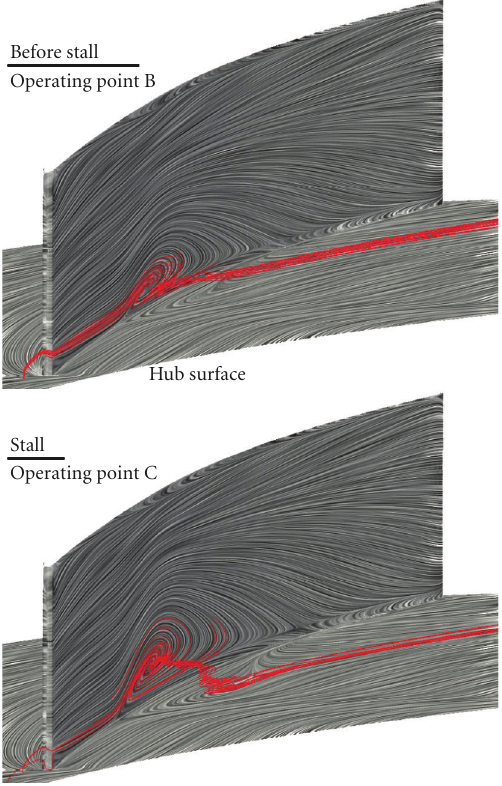
Figure 11: Hub-suction side corner separation 3D streamlines.